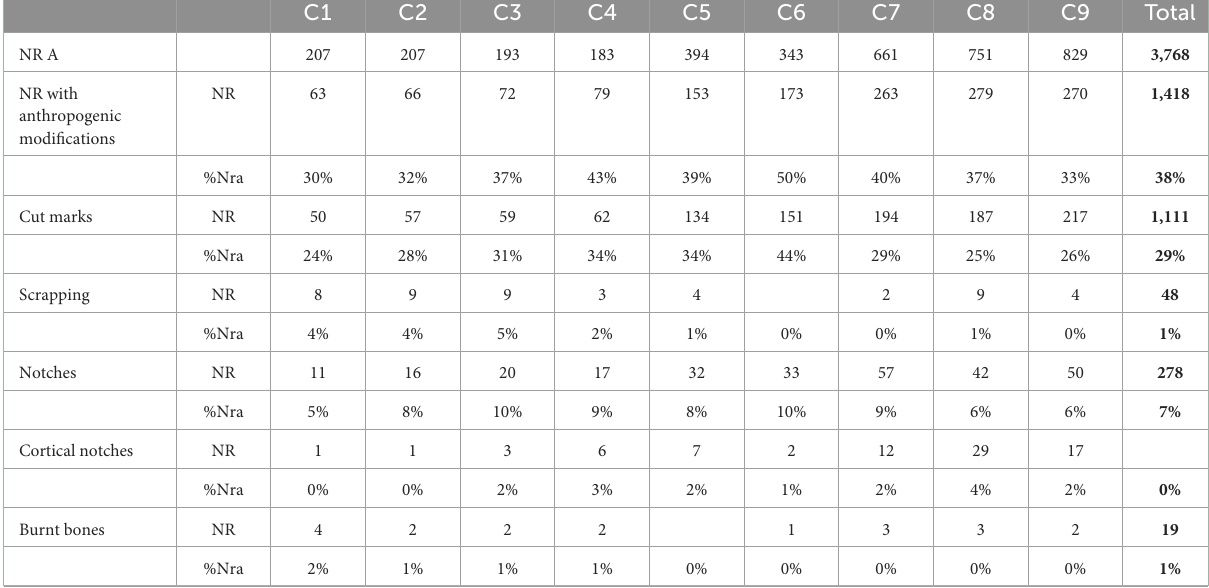
TABLE 4 Anthropogenic modifications. NRA: Number of analyzed remains.